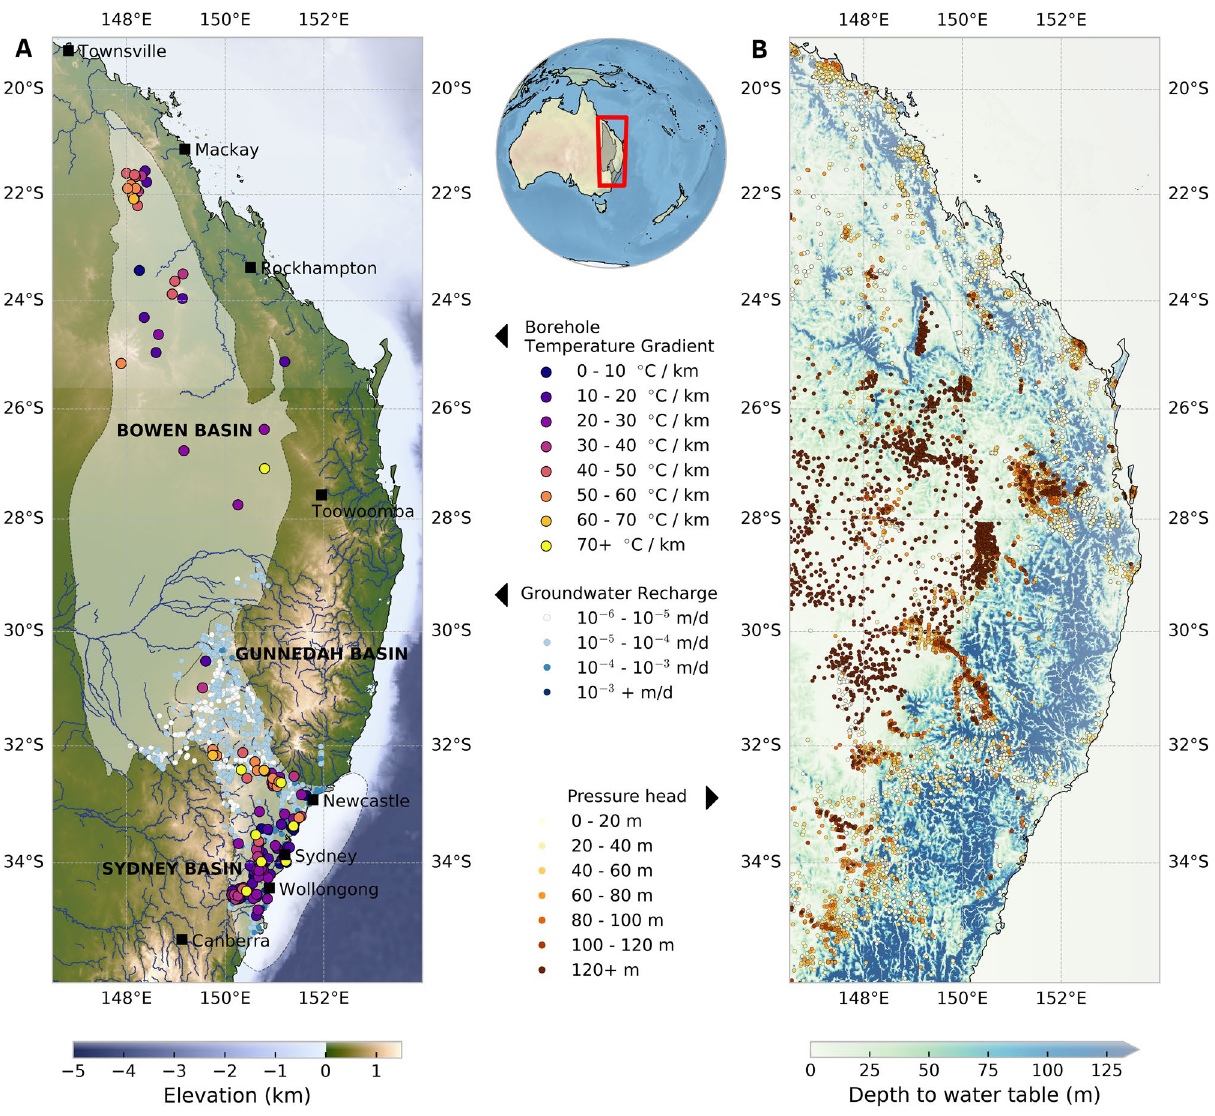
Figure 1. The boundary of our model covers much of the eastern third of Australia with the Sydney– Gunnedah–Bowen Basin highlighted in white. Multiple data types are used to constrain our coupled groundwater-heatflow models, including maps of ( A ) elevation of the study area overlain with borehole measurements of temperature gradients 19 and groundwater recharge rates 9 . Blue lines indicate major perennial streams. ( B ) The depth to the water overlain with the hydraulic pressure head ( h P = P /ρ w g in metres) measured in groundwater boreholes (Table S1). Satellite imagery was obtained from the ETOPO1 global relief model 20 .